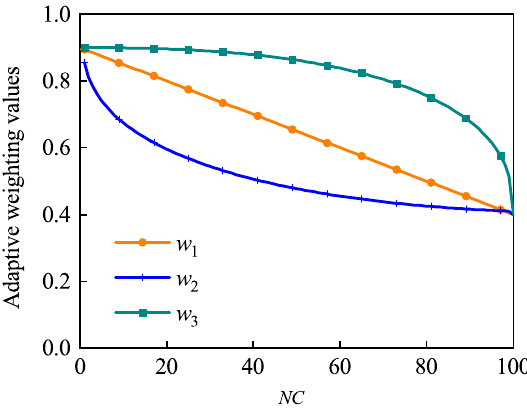
Figure 6. Schematic of different weighting